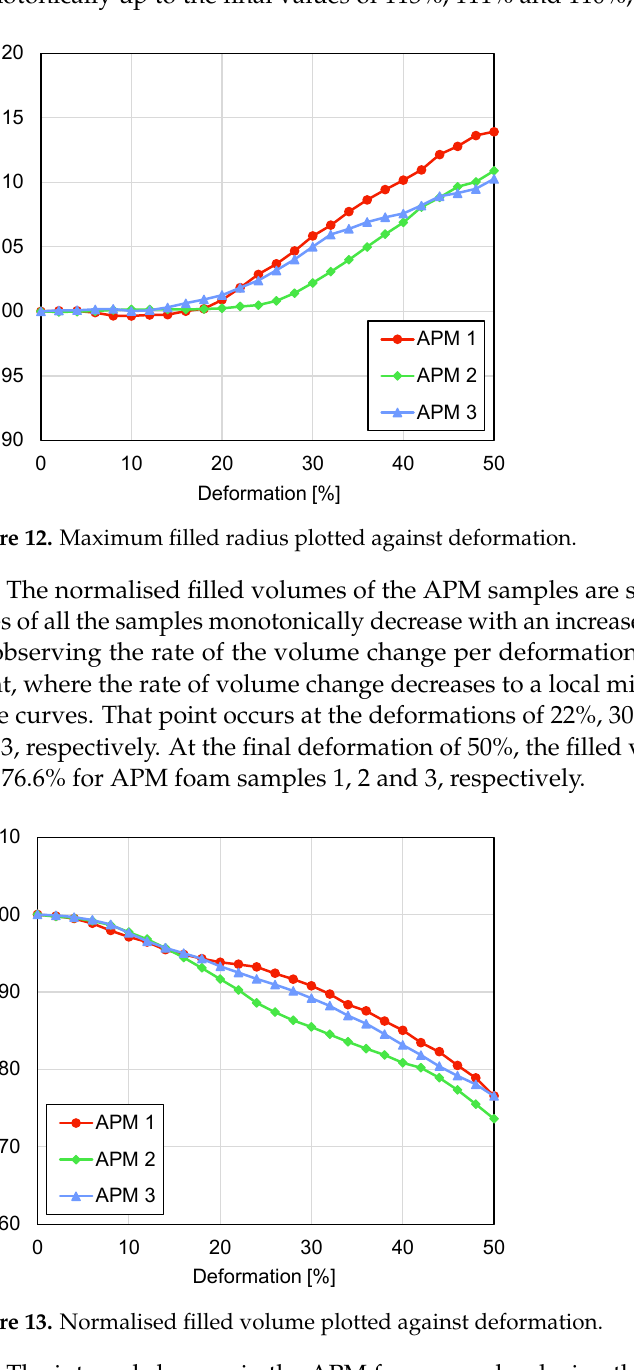
Figure 13. Normalised filled volume plotted against deformation.